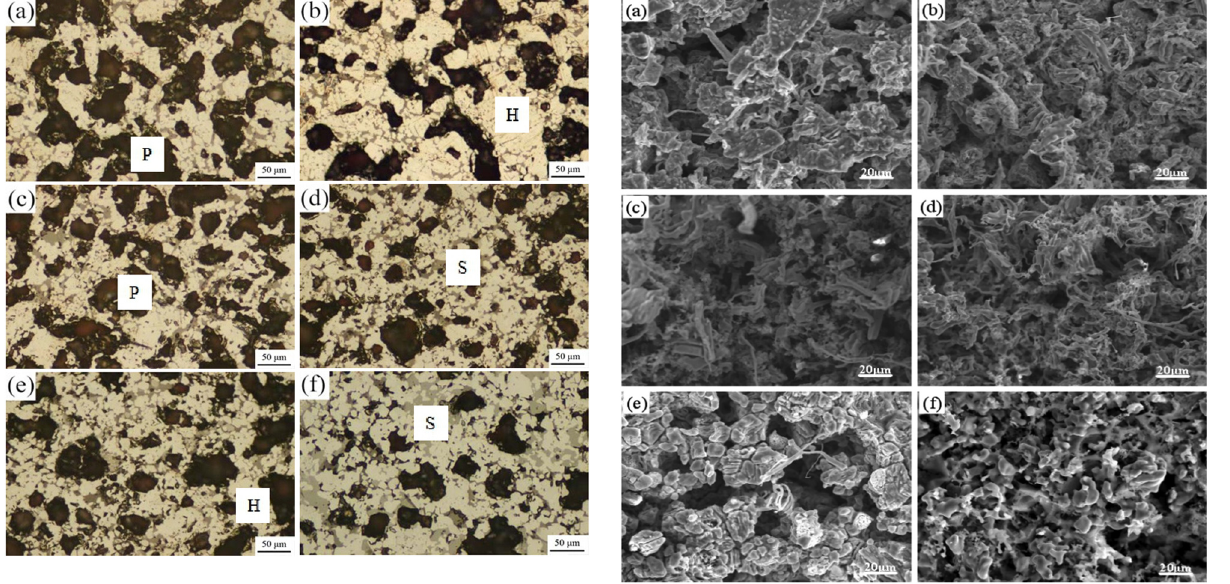
Figure 7: SEM - EDS images of briquettes with di ff erent basicity values after reduction. ( a ) – ( f ) Briquette specimens #1 ( 0.2 ) , #2 ( 0.4 ) , #3 ( 0.6 ) , #4 ( 0.8 ) , #5 ( 1.0 ) , and #6 ( 1.2 )